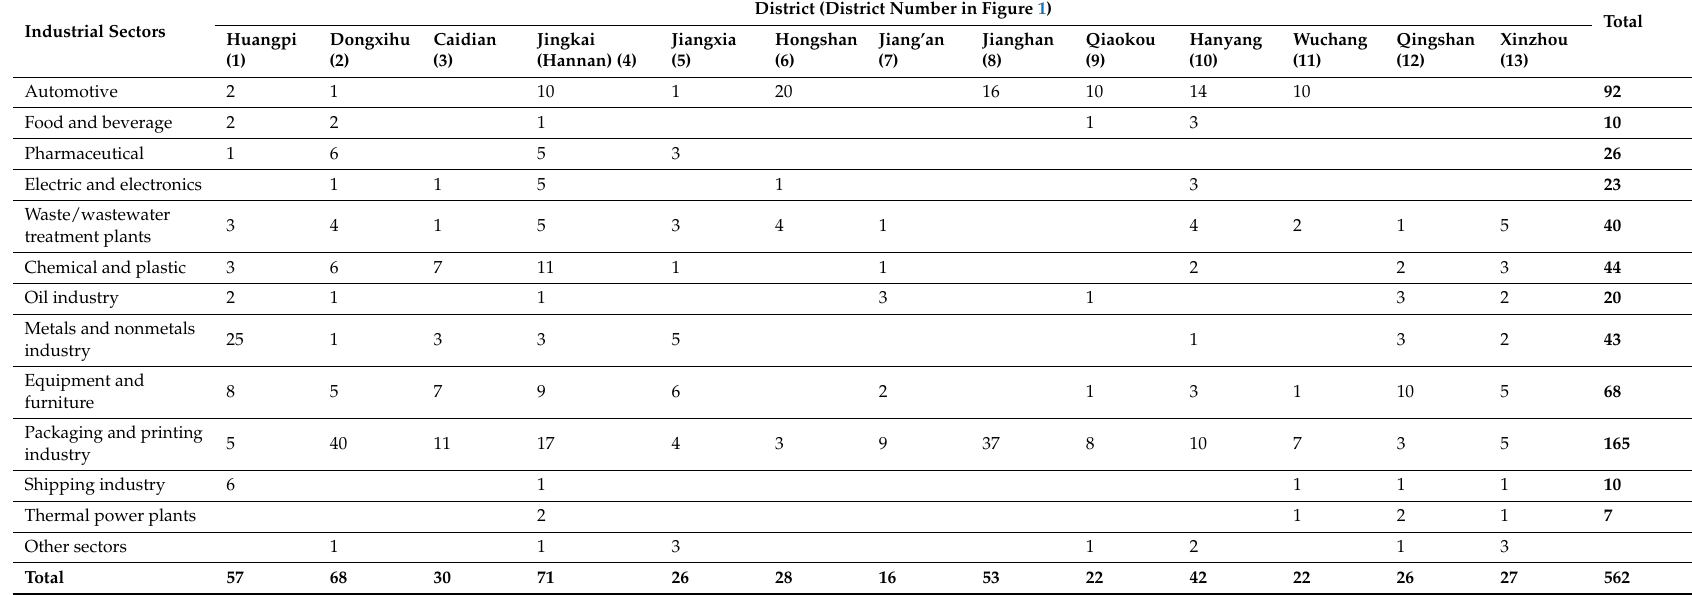
Table 1. Volatile organic compounds (VOCs) source categories and number of companies for different districts of